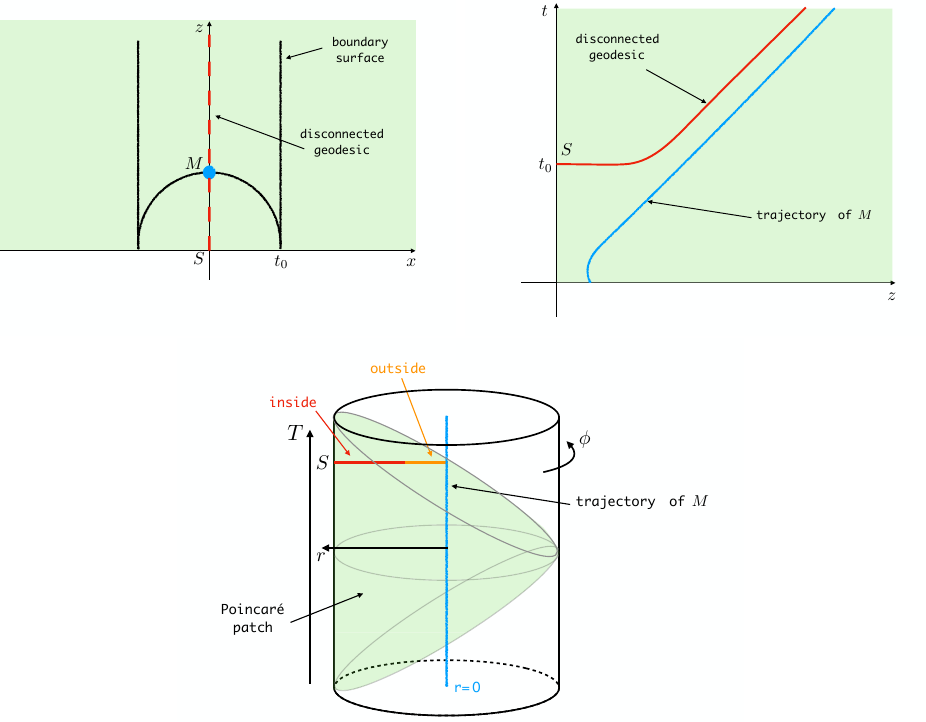
Figure 24 . The left figure shows a time slice in Poincar´e coordinate ( t, x, z ). For simplicity, let us set the start point S of the disconnected geodesic to be ( t 0 , 0 , 0). The red dashed line shows how the geodesic extending from S looks like when projected on the time slice. Note that this geodesic does not lie on the time slice. The blue point M is the middle point of the boundary surface. The right figure shows how these look like on x = 0. The lower figure shows how these looks like in a global coordinate ( T, r, φ ). This coordinate is taken to satisfy that M stays at r = 0. The Poincar´e patch is shaded green in all three figures. The geodesic has an inside part (red) and an outside part (yellow). Its length is given by log( t/(cid:21) ) + log( t/a